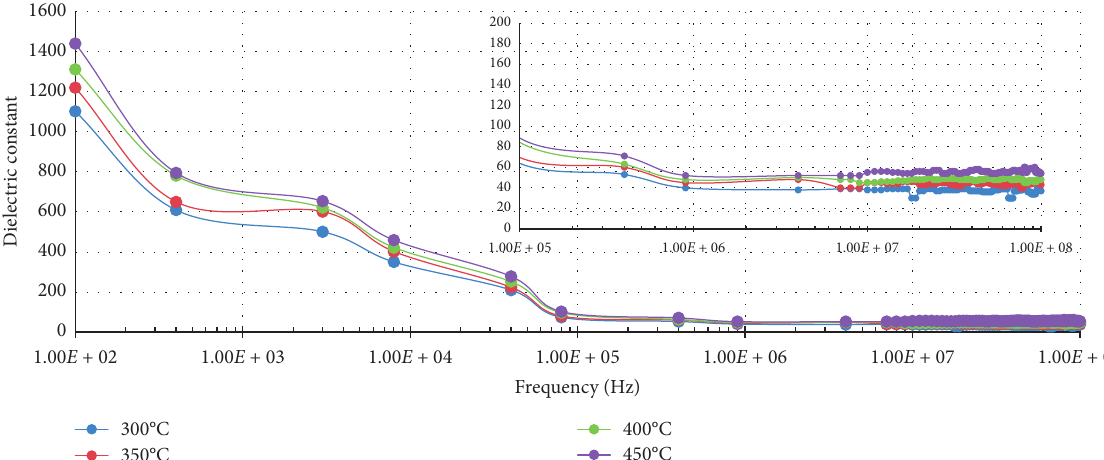
Figure 8: Dielectric properties of SnO 2 powders with different calcination temperatures as a function of driven